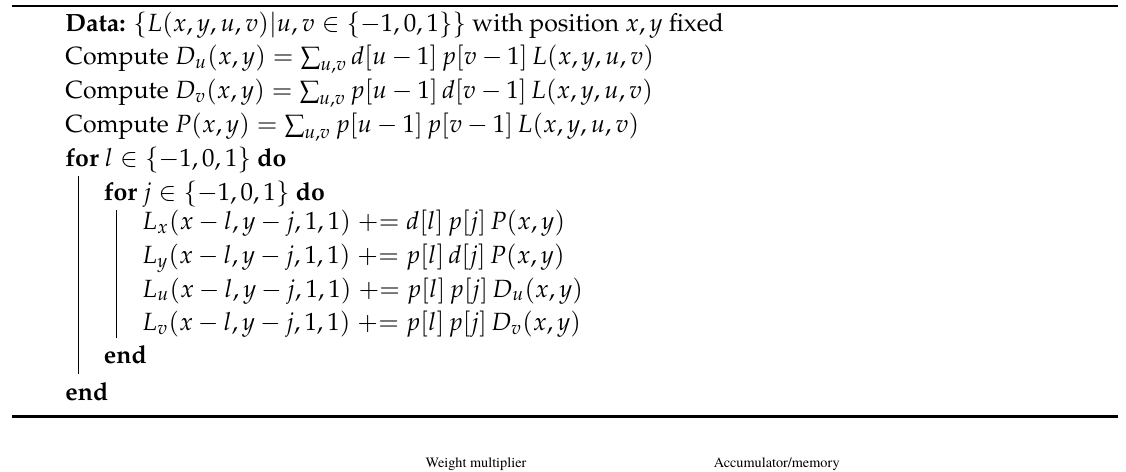
Algorithm 3: Computation of partial result for a given parallel input pixel set.